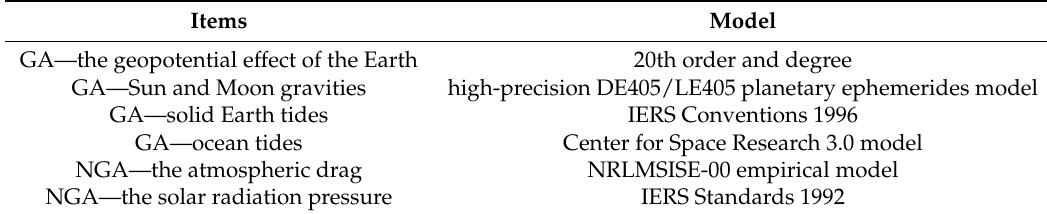
Table 1. Accelerations of gravitational and non-gravitational models.